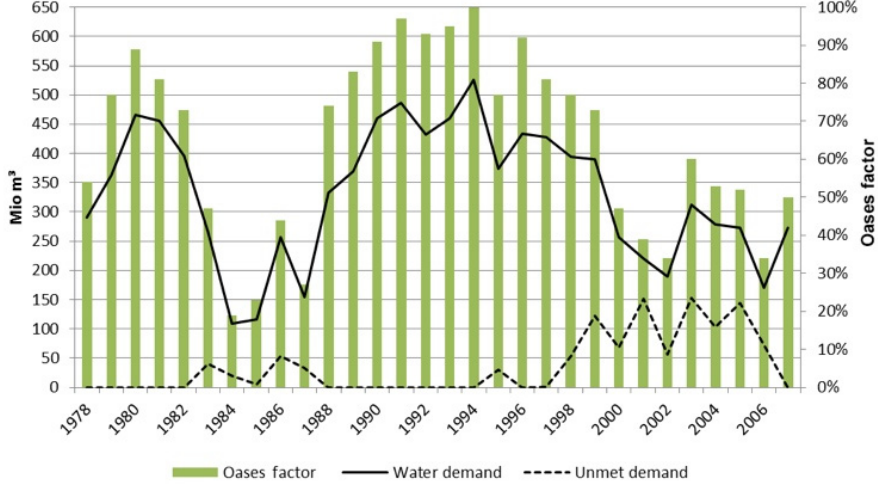
Figure 4. Mean annual water and unmet water demand in the six oases for the period of 1978 to 2007 in relation to the oases factor determining field size. The oases factor shows a strong correlation to the total water demand.